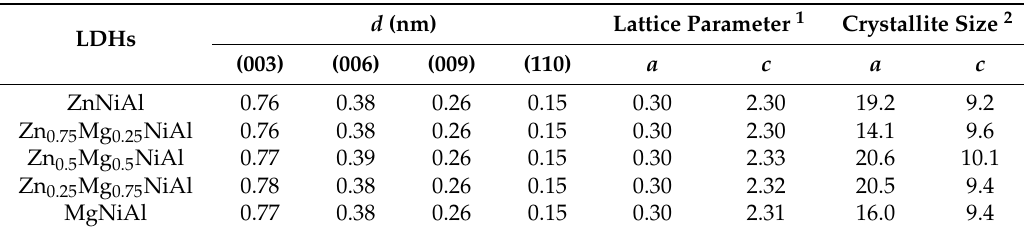
Table 1. Analysis of XRD patterns for Zn x Mg 1 − x NiAl LDHs. d (nm) Lattice Parameter LDHs